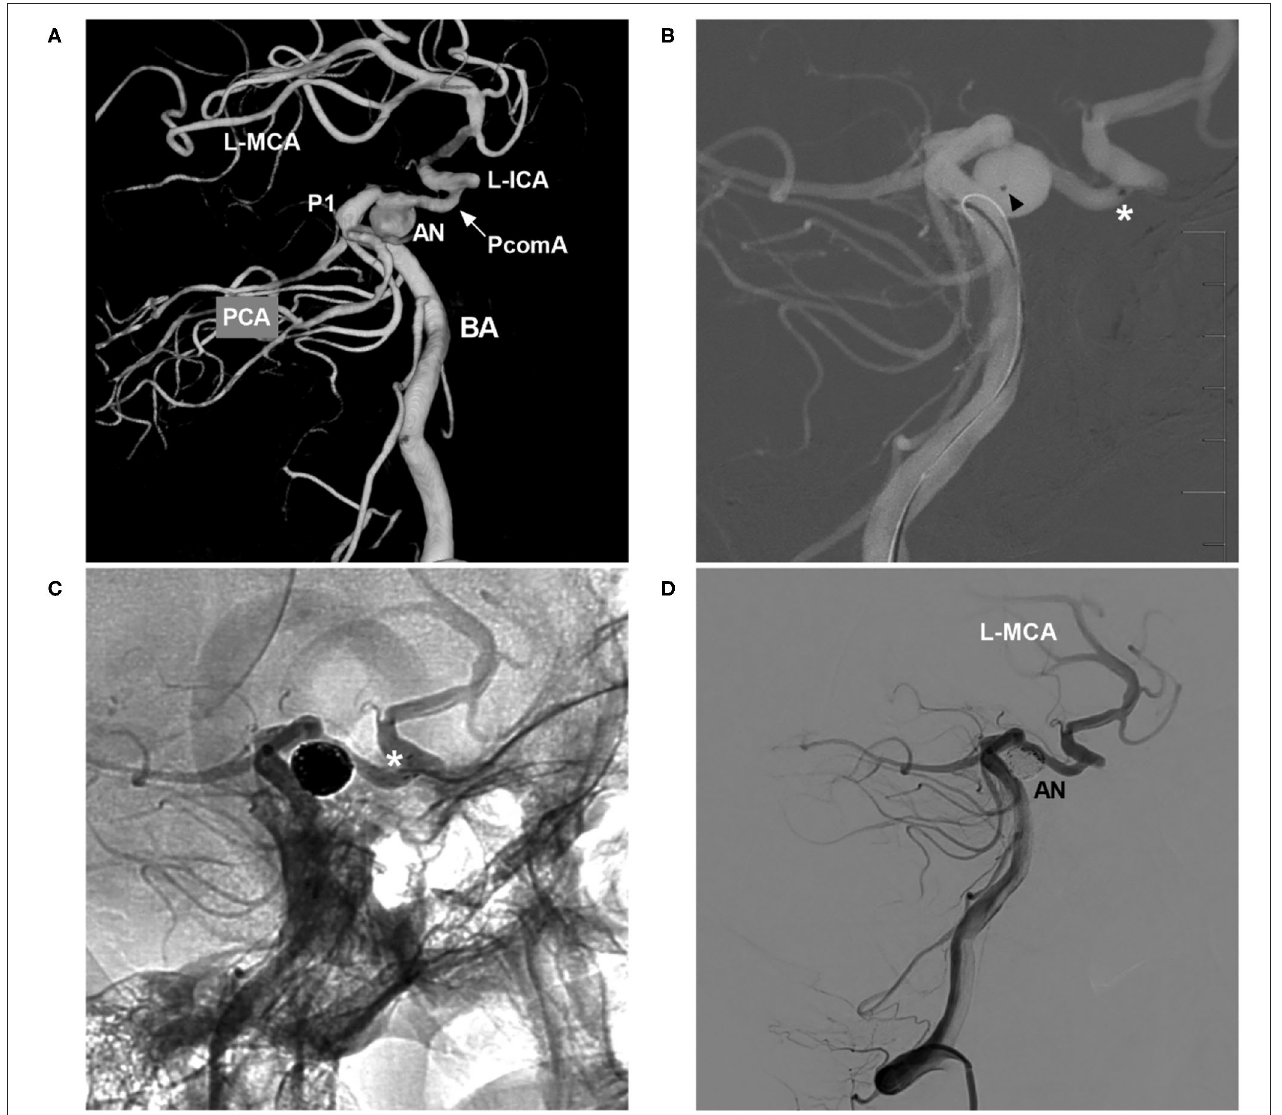
FIGURE 7 | NAS-assisted coiling of a PcomA aneurysm with coil delivery from the posterior circulation to the anterior circulation. (A) Three-dimensional DSA of the BA showing occlusion of the left ICA, with the posterior circulation supplying the left MCA via the PcomA (arrow) and an aneurysm (AN) located at the left PcomA trunk near the PCA. (B) Map showing the positioning of the NAS delivery microcatheter (the asterisk indicates the distal marker) and the coil delivery microcatheter (the triangle indicates the tip) from the posterior circulation. (C) Unsubtracted DSA showing NAS deployment (the white asterisk shows the distal marker). (D) Postoperative DSA of the VA showing complete occlusion of the aneurysm (AN). AN, aneurysm; BA, basilar artery; DSA, digital subtraction angiography; ICA, internal carotid artery; L, left; MCA, middle carotid artery; NAS, Neuroform Atlas stent; P1, first segment of the PCA; PCA, posterior cerebral artery; PcomA, posterior communicating artery; VA, vertebral